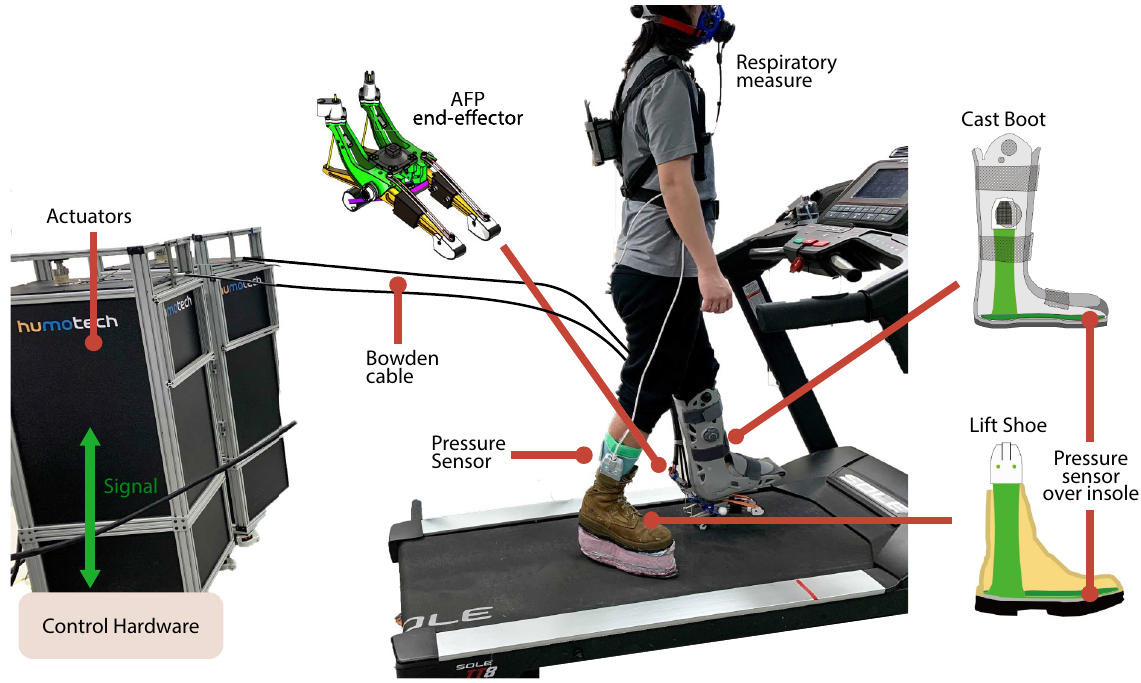
Figure 4. Experimental setup: tethered ankle-foot prosthesis emulator with a cast boot to immobilize the ankle and lift shoe for individuals with simulated amputation. The pressure sensors (green) were located at the insole of the lift shoe and the cast boot. The pressure sensor and respiratory data were used to develop a cost function and to evaluate the performance of the cost function in the HIL optimization